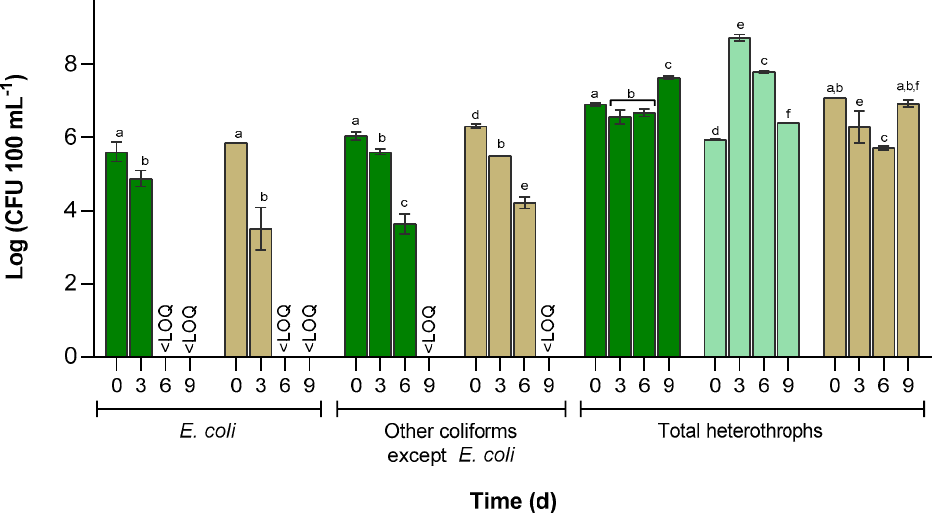
Figure 7. Quantification of E. coli , other faecal coliforms except E. coli , and total heterotrophs over time (d) for each PBR: (cid:4) CV ( C. vulgaris + UWW); (cid:4) C+ ( C. vulgaris + autoclaved UWW); and (cid:4) C − (raw UWW). Results are expressed in log (CFU 100 mL − 1 ) (average ± standard deviation). Bars from the same group of bacteria with a common superscript letter are not statistically different (two-way ANOVA followed by Tukey post hoc test p >